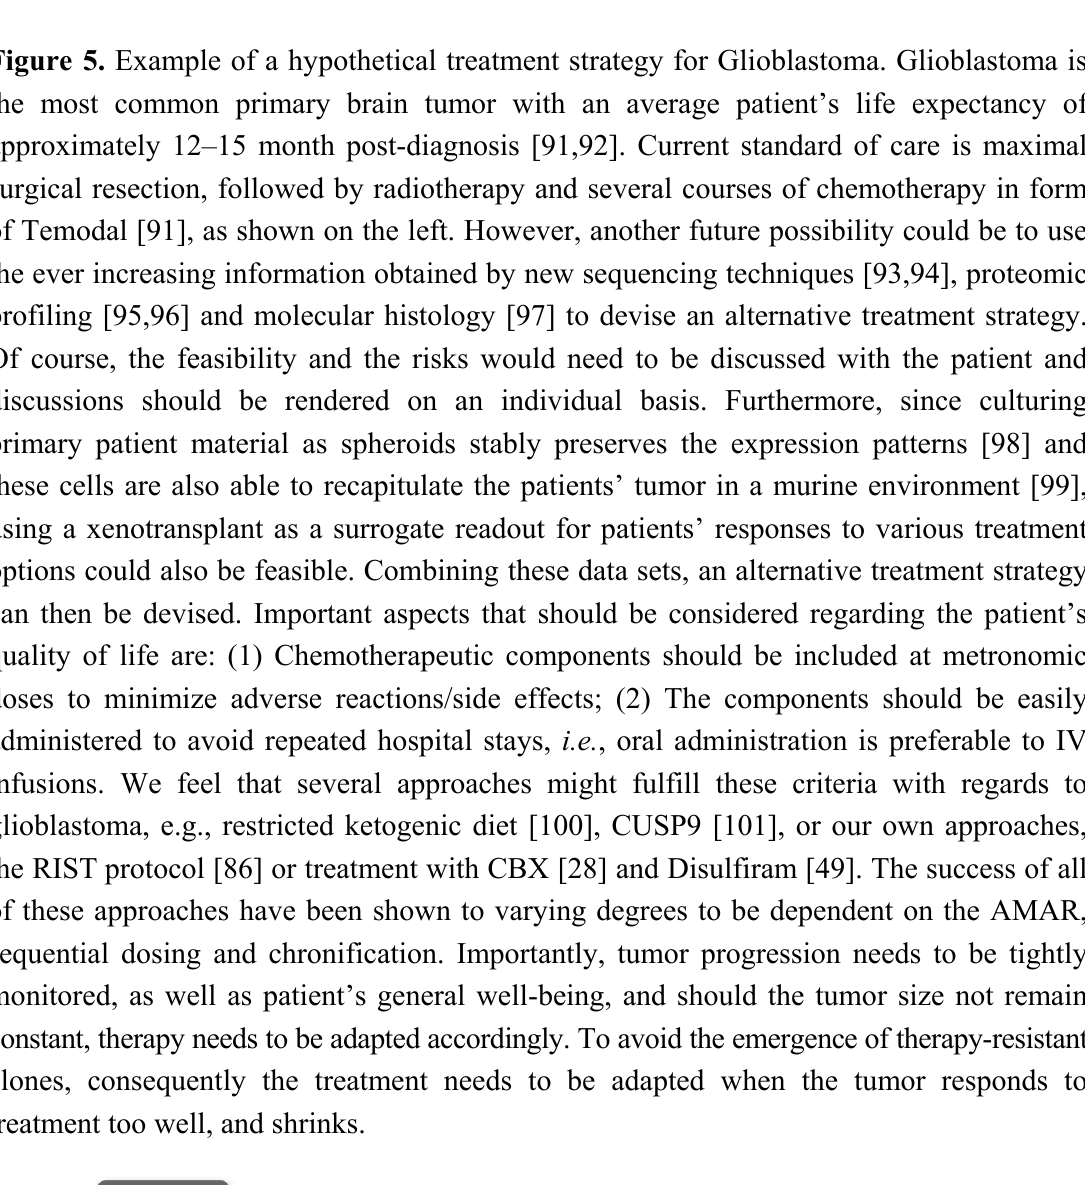
Figure 5. Example of a hypothetical treatment strategy for Glioblastoma. Glioblastoma is the most common primary brain tumor with an average patient’s life expectancy